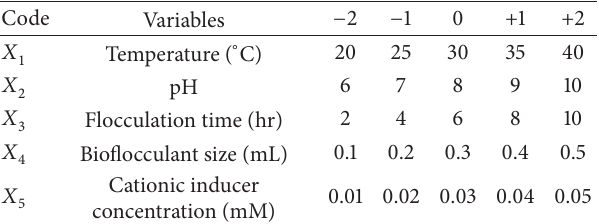
Table 1: Coded values based on the factor at a time experiment for the 5 variables employed in the study.